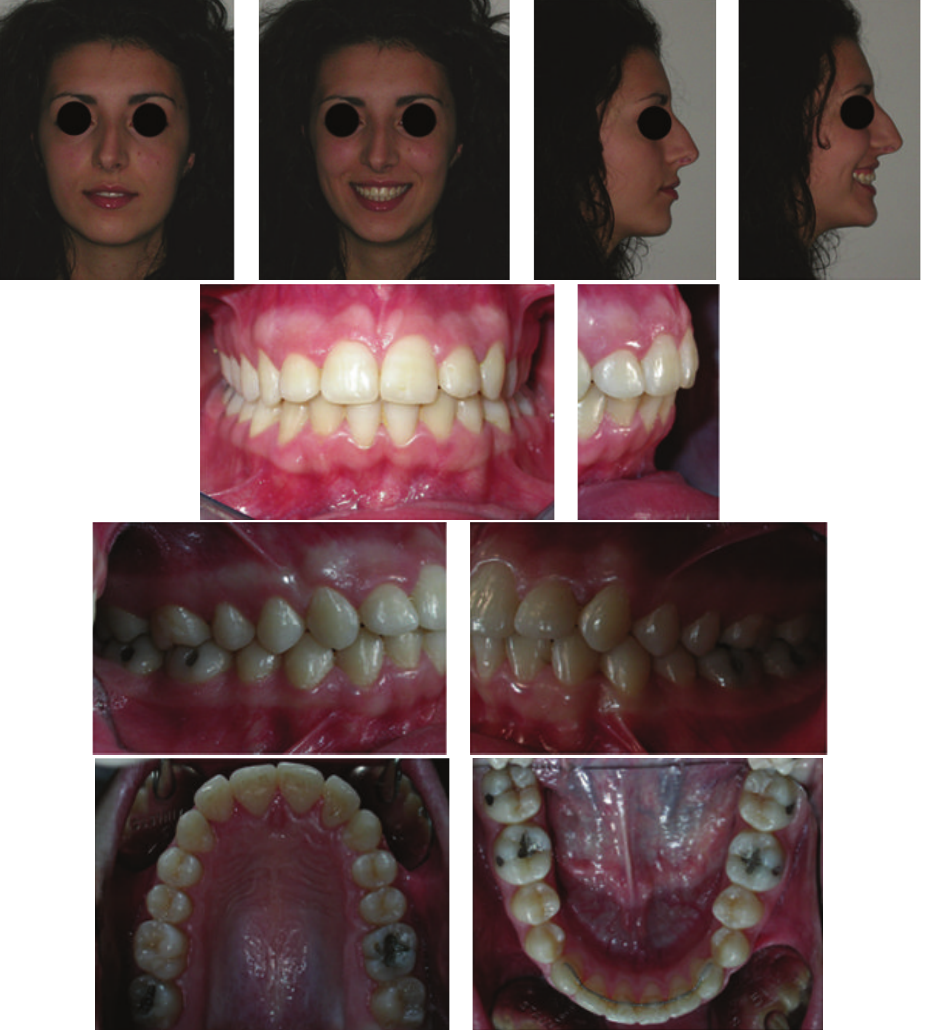
Figure 11: Extraoral and intraoral photographs at two-year